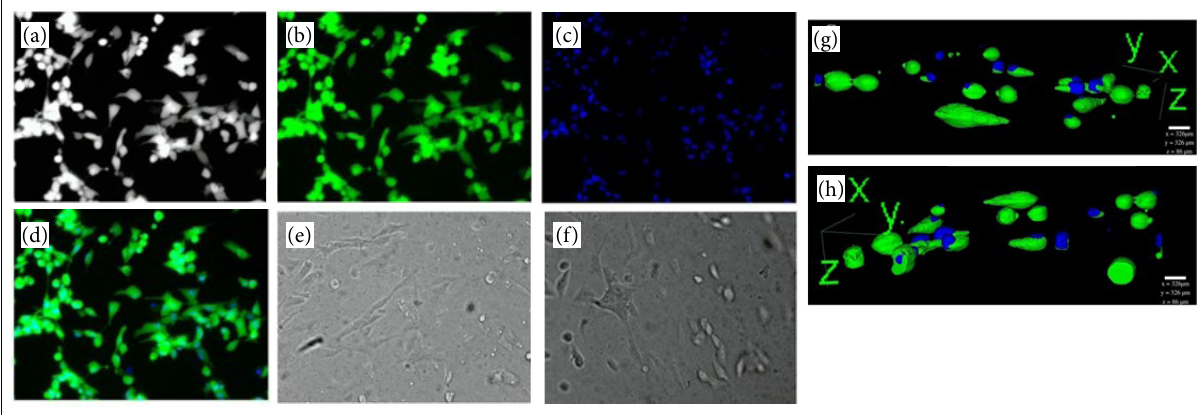
Figure 10 - Tridimensional (3D) fibroblast cell culture in hydrogel. The control of this experiment ( a-d ) are fibroblast cultivated in monolayer. (a) Fibroblast in grayscale. (b) Cytoplasm labeled with Calcein AM. (c) Nucleus labeled with Hoechst. (d) Overlaid fluorescence of cytoplasm and nucleus. ( e and f ) The control of 3D fibroblasts in hydrogel in grayscale. ( g and h ) 3D fibroblast in hydrogel labeled with Calcein AM and Hoechst rendered